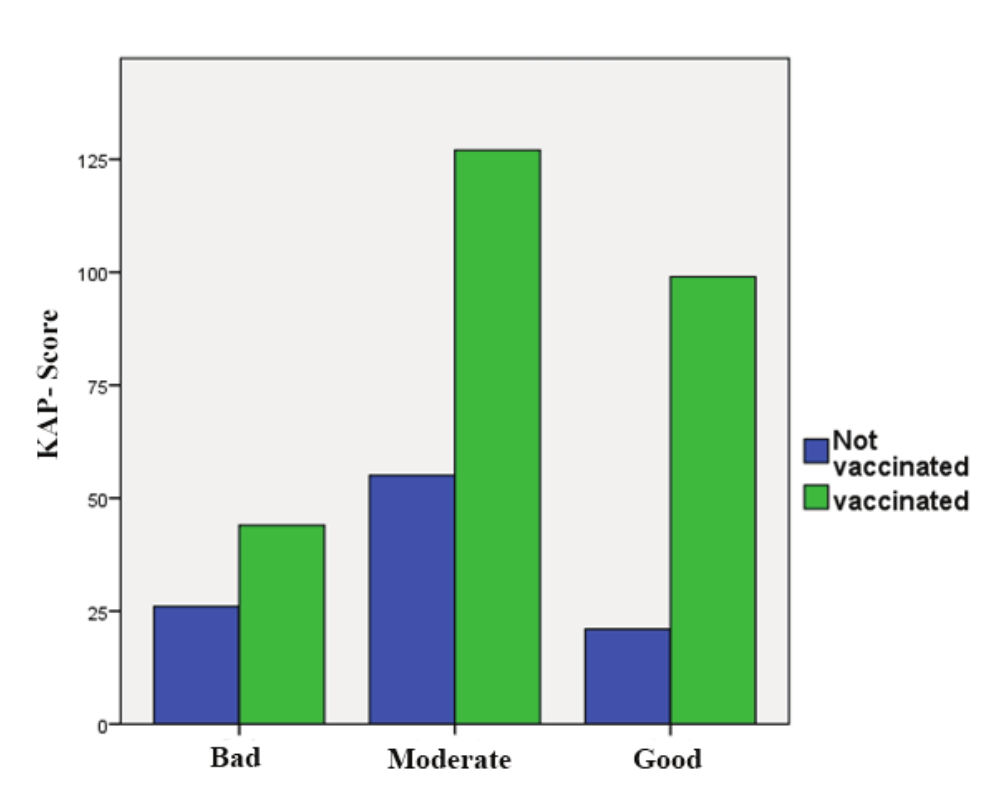
Figure 1: Association between the average KAP score of the respondents and their vaccination